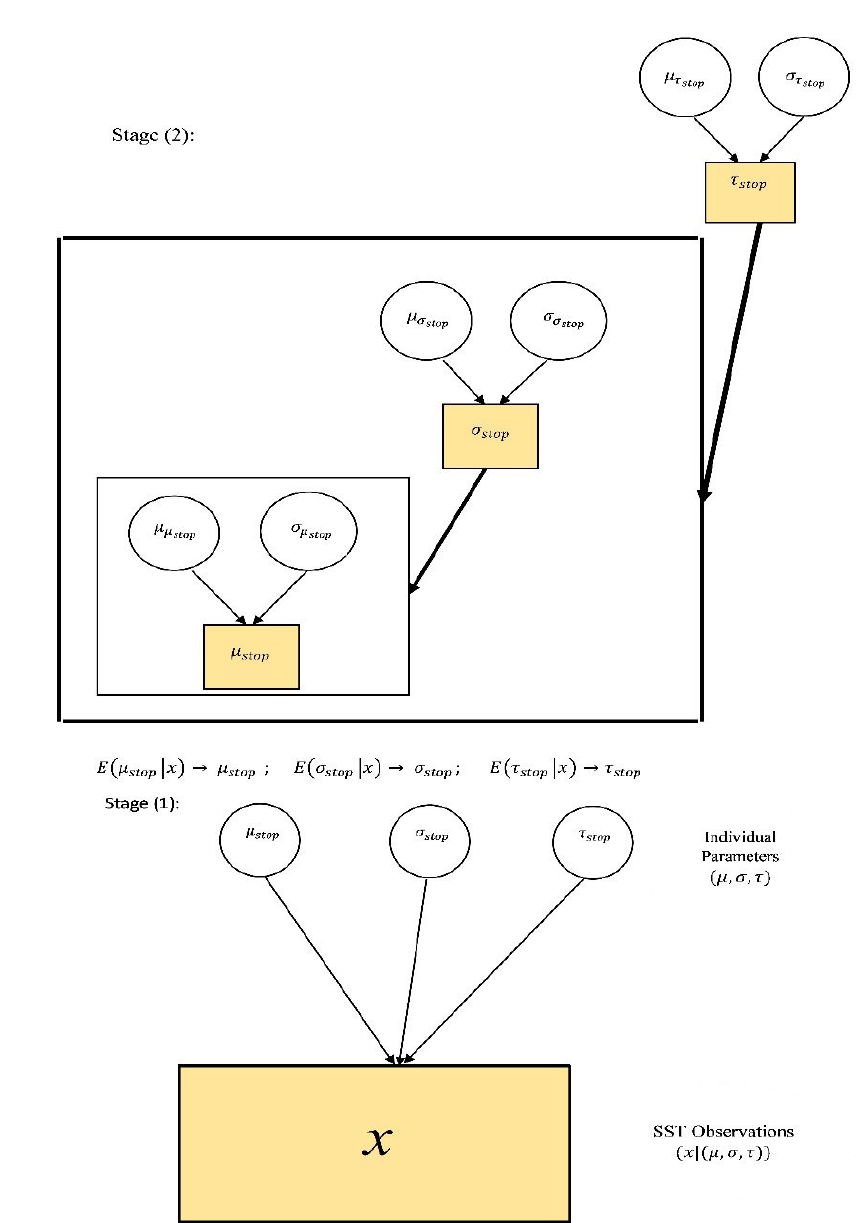
Figure 4. Two -Stage Bayesian Parametric Approach (TSBPA) with ex-Gaussian distributional assumption framework. Filled in shapes indicate known